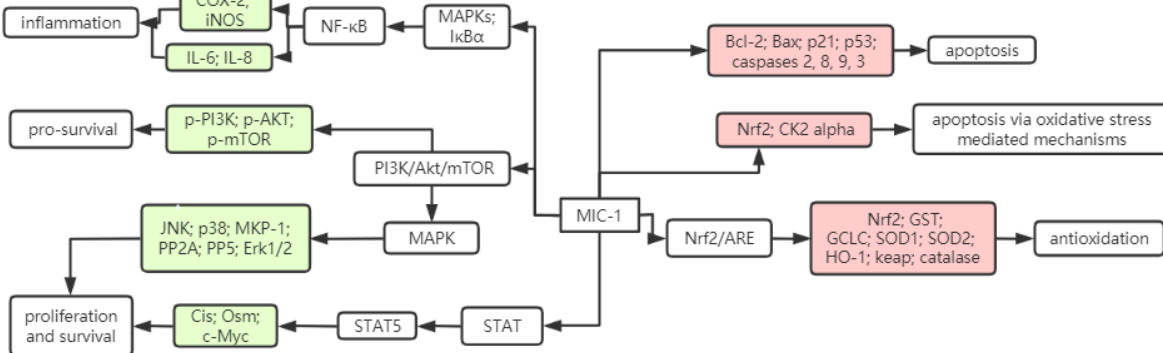
Figure 3. Proposed molecular target of MIC-1 as an anti-cancer agent. This figure is some of the signaling pathways that MIC-1 participates in cancer cells, as well as the proteins and genes regulated by these signaling pathways. Green boxes represent the downregulated genes or proteins, and red boxes represent the upregulated genes or proteins. COX-2: Cyclooxygenase-2; iNOS: Inducible nitric oxide synthase; IL-6: Interleukin-6; IL-8: Interleukin-8; JNK: c-Jun NH2-terminal kinase; p38: p38 Mitogen-activated protein kinase; MKP-1: Mitogen-activated protein kinase phosphatase-1; PP2A: Protein phosphatase 2A; Erk1/2: Extracelluar signal-regulated kinase 1/2; p-PI3K: Phosphorylated phosphatidylinositol 3-kinase; p-AKT: Phosphorylated protein kinase B; p-mTOR: Phosphorylated mammalian target of rapamycin; Cis: Cytokine-inducible SH2-containing protein; Osm: Oncostatin M; c-Myc: MYC proto-oncogene; Bcl-2: B-cell lymphoma 2; Bax: BCL2-associated X protein; p21: Cyclin-dependent kinase inhibitor 1; p53: Tumor suppressor p53; Nrf2: Nuclear factor erythroid-2-related factor 2; CK2: Casein kinase 2; GST: Glutathione S-transferase; GCLC: glutamate-cysteine ligase catalytic subunit; SOD1: Superoxide dismutase 1; SOD2: Superoxide dismutase 2; HO-1: Heme oxygenase 1; STAT: Signal transducer and activator of